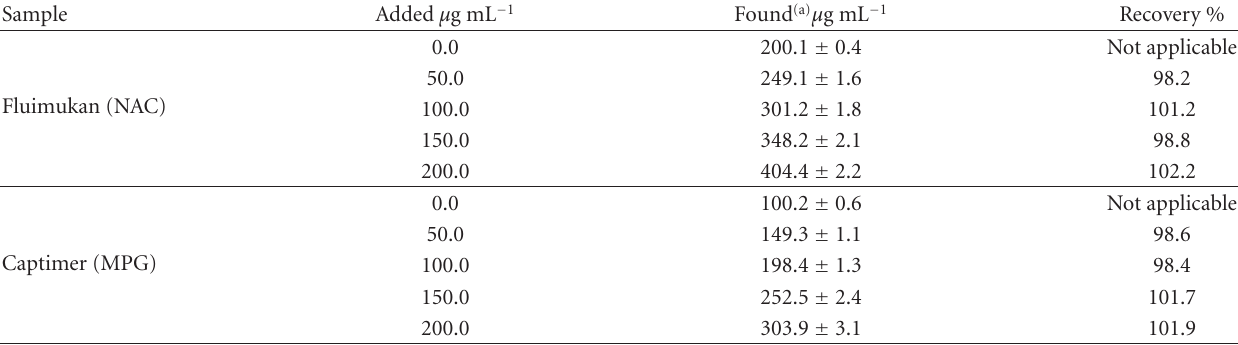
Table 3: Accuracy (recovery, %) of the proposed method for the determination of NAC and MPG in two pharmaceutical formulations.